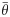
Coupled ring network (model B) with inhibitory intralaminar connections.(a) Plot of the potential function ϕ(β) for threshold η = 0.5 and gain η = 4. The solid curve is an approximation based on a fitted von Mises distribution ϕ(β) ≈ 12M(β; 0, 0.6) − 0.9. (b) Plot of normalized mean 〈U〉/A of ring network 1 (center mean) as a function of the directional bias θ¯ of the input to network 2 (surround bias) for various coupling parameters χ. (c) Corresponding plots of normalized variance var(U1)/A2 of ring network 1 (center variance) as a function of the surround bias for various coupling parameters χ. Stimuli to networks 1 and 2 are h¯cosθ and h¯cos(θ-θ¯), respectively, and we take κ = 1.